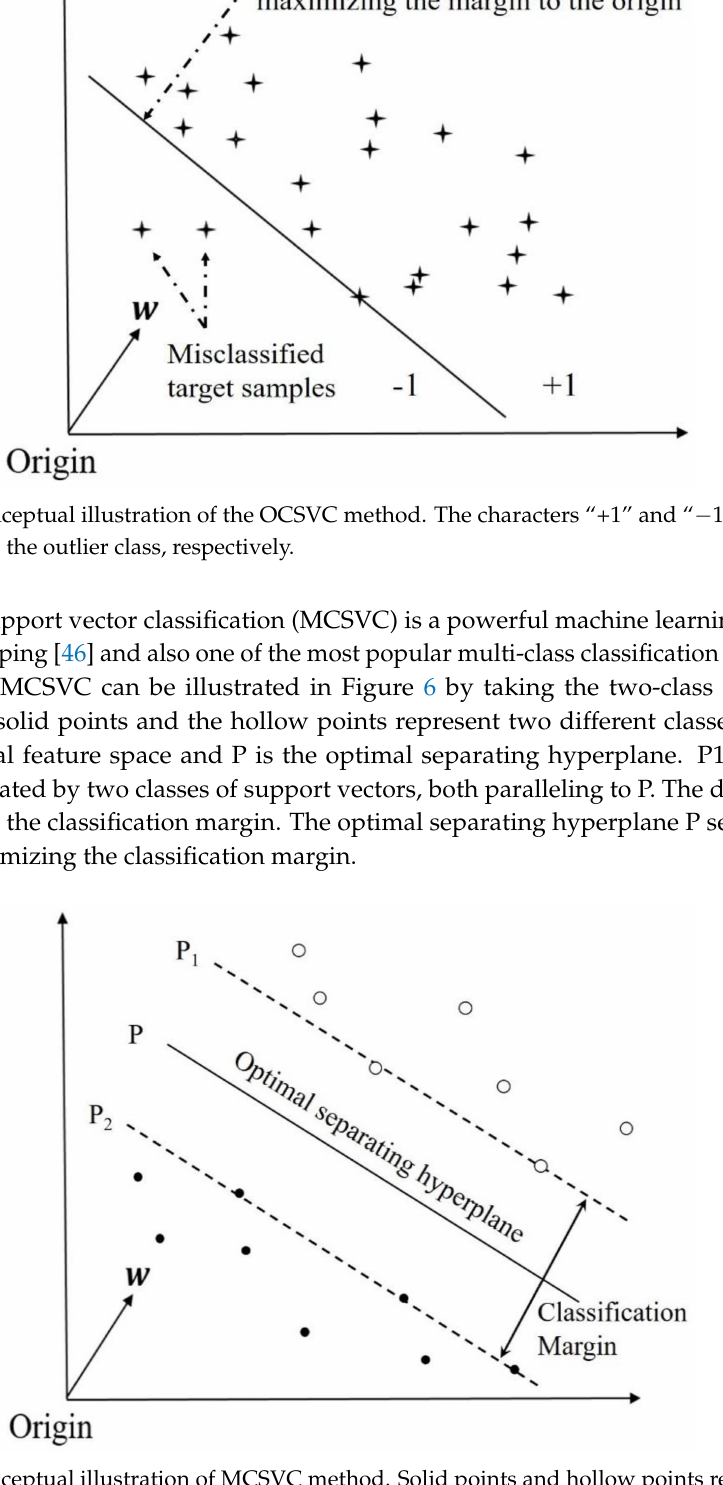
Figure 6. A conceptual illustration of MCSVC method. Solid points and hollow points represent two different